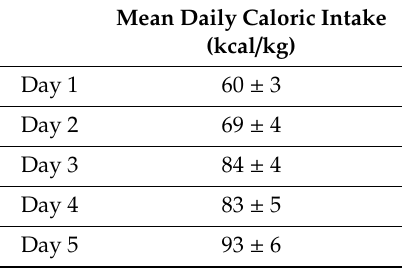
Table 1. Mean daily caloric intake. Caloric intake are expressed as kcal / kg of body weight for each day on parenteral nutrition (PN) or PN enriched with GSSG. The daily caloric intake increased with time (F (4,65) = 8.20, p < 0.001) reaching a plateau at the third day (F (1,65) ≤